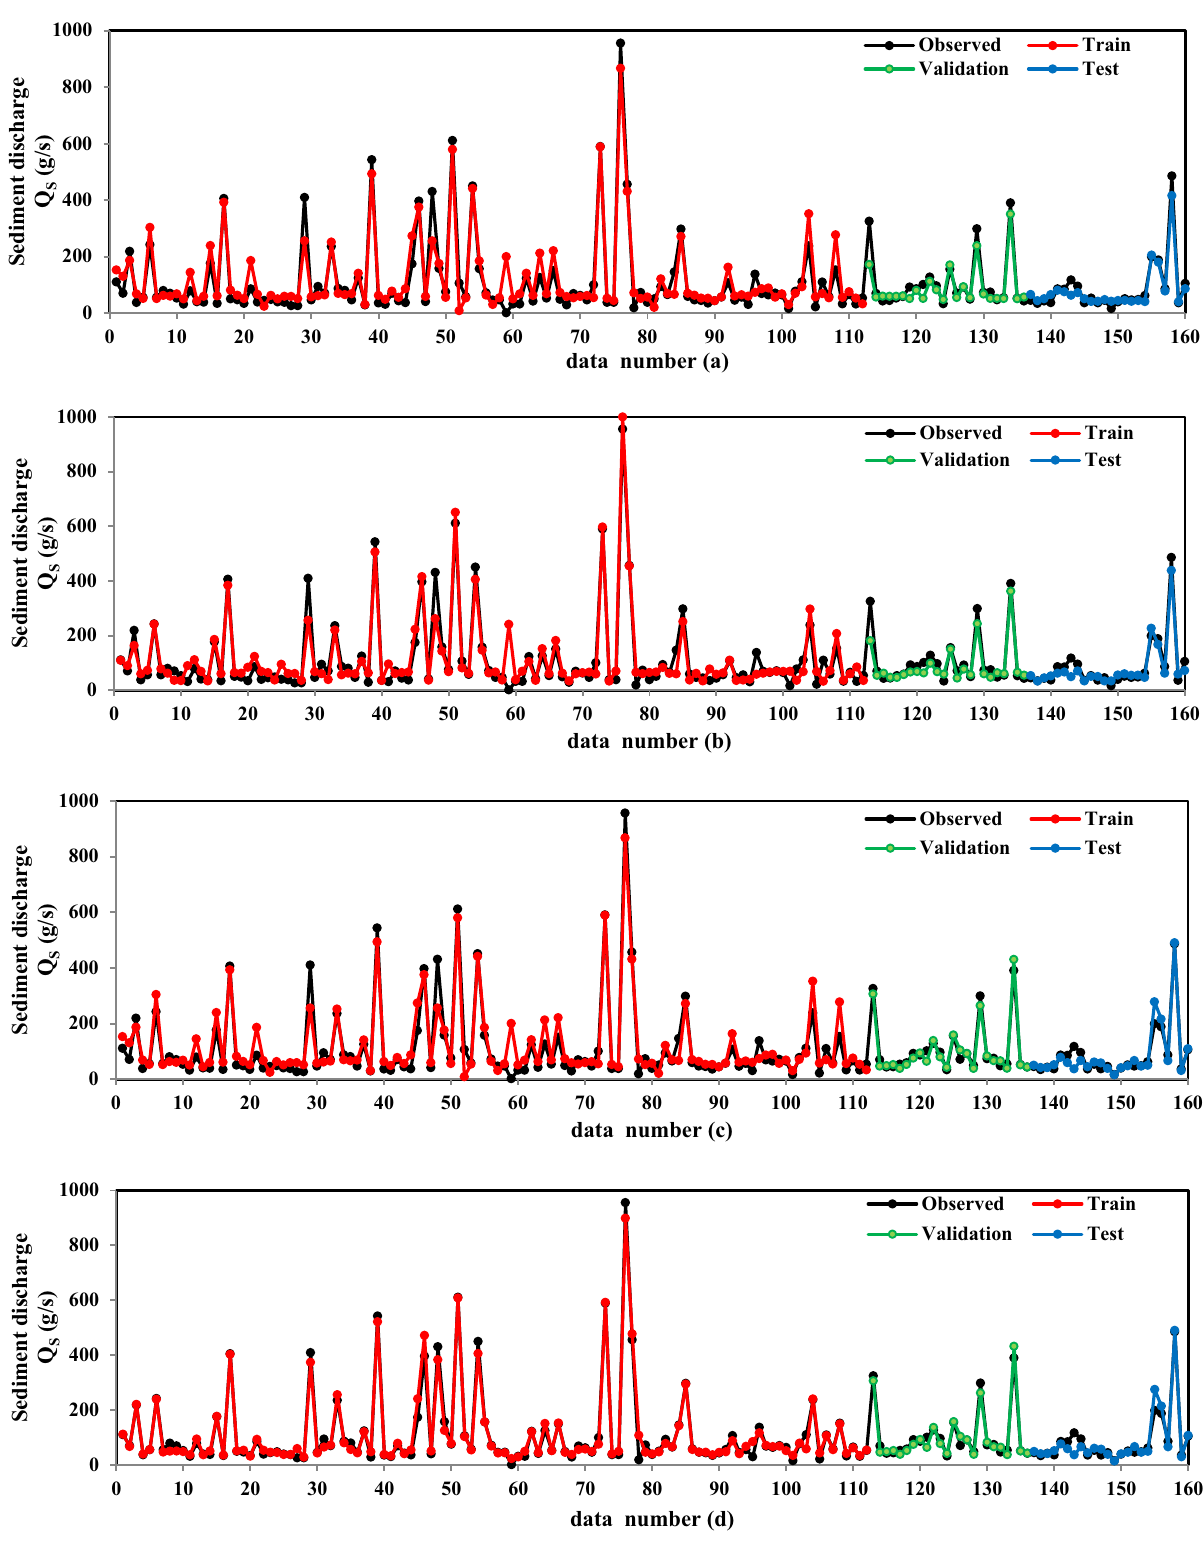
Figure 4. Performance of the best models in sediment discharge prediction in the training, validation, and testing phases ( a ) GMDH-HGSO; ( b ) GMDH-EO; ( c ) SVR-HGSO; ( d )